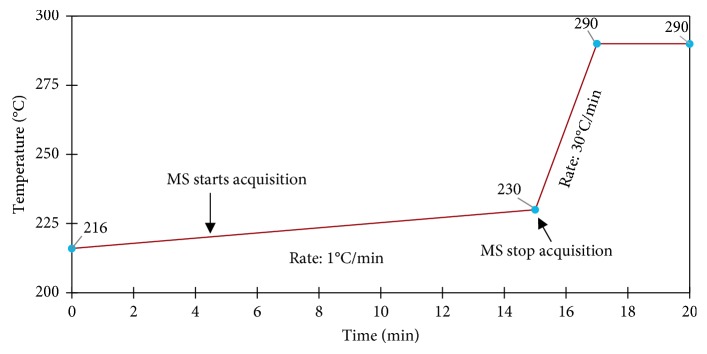
GC oven program.